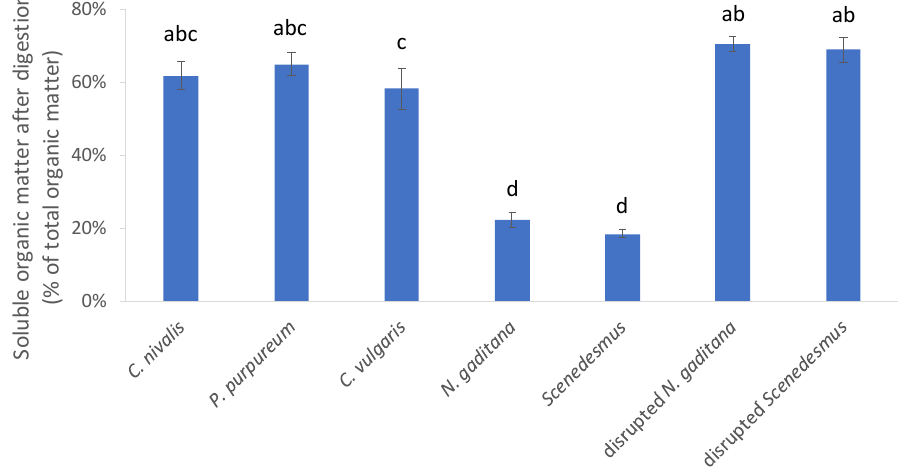
Figure 1. Organic matter soluble after digestion, expressed as a percentage of the initial organic matter level. Values that are not labeled with a common letter are significantly different.